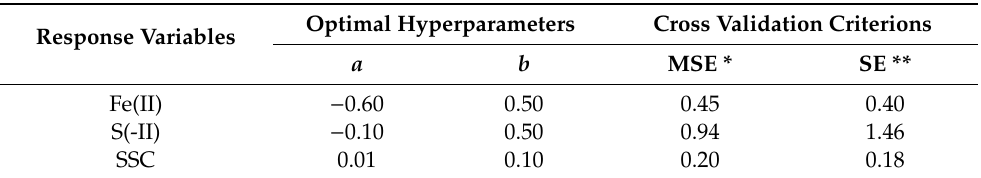
Table 3. Optimal